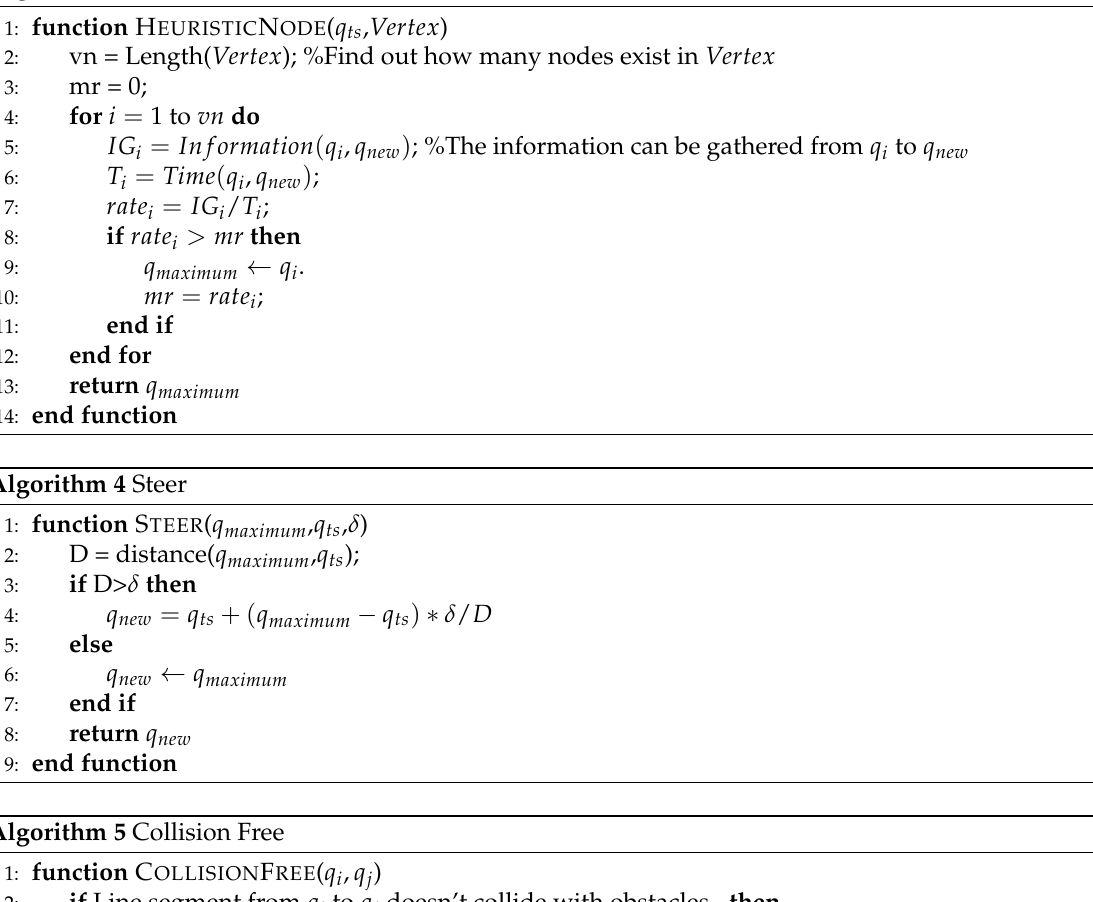
Algorithm 3 Heuristic Node